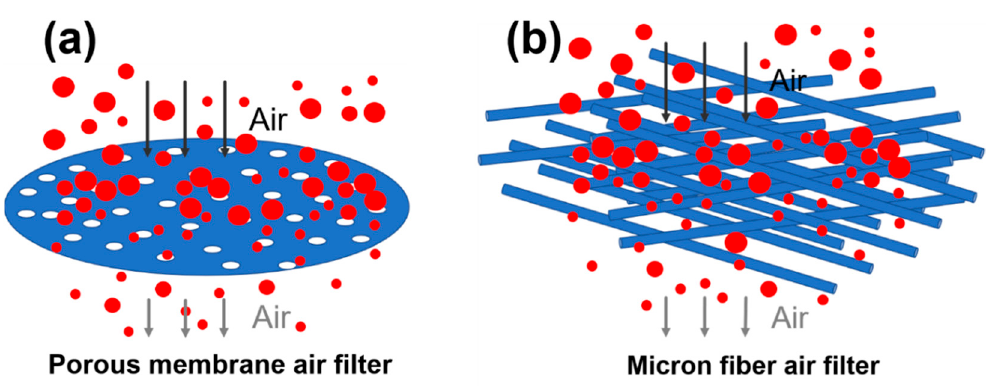
Figure 1. Comparison among different air filters. ( a ) Filter principle diagram of porous membrane air filter; ( b ) filter principle diagram of micron fiber air filter.